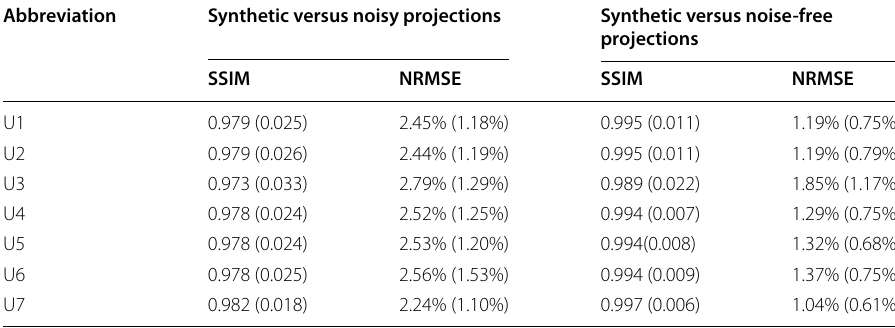
Mean SSIM and NRMSE values between synthetic projections and noisy/noise‑free projections, respectively. Data in parentheses are standard deviations